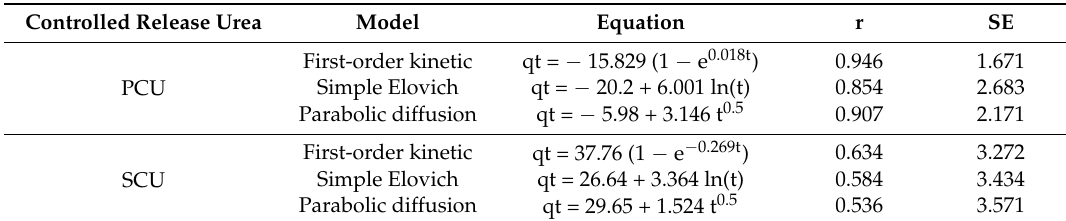
Table 5. Kinetics equations, correlation coefficients (r), and standard errors (SE) of nitrogen release of PCU and SCU in soil.